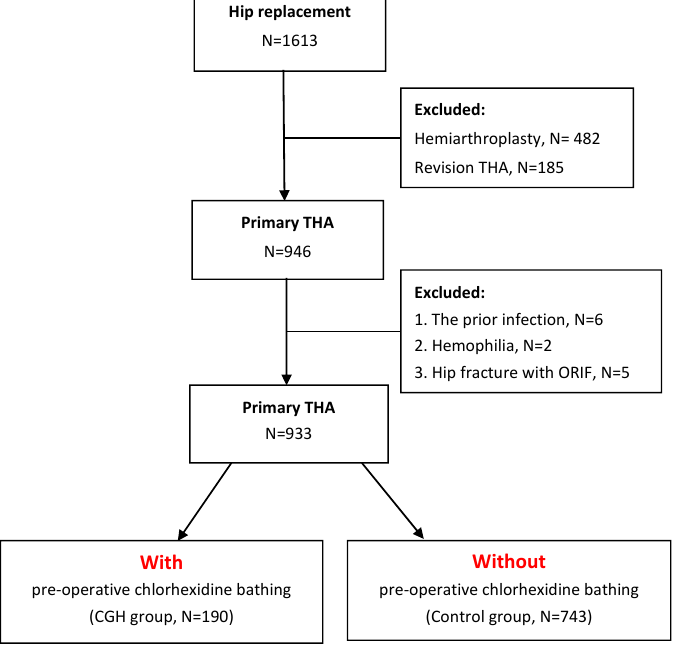
Figure 1. The flowchart of primary THA cases enrollment